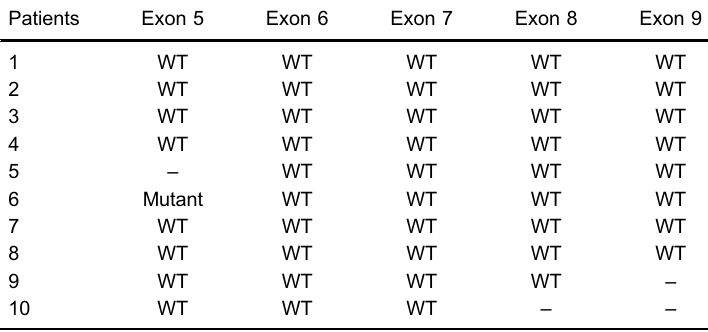
Genomic DNA was extracted from formalin- fi xed and paraf fi n - embedded tissues and exons 5 – 9 of TP53 gene were ampli fi ed by PCR and directly sequenced in both directions. No mutations were found in tumor samples except for patient #6, who presented two missense mutations (P142S and H179Y). WT: wild type.